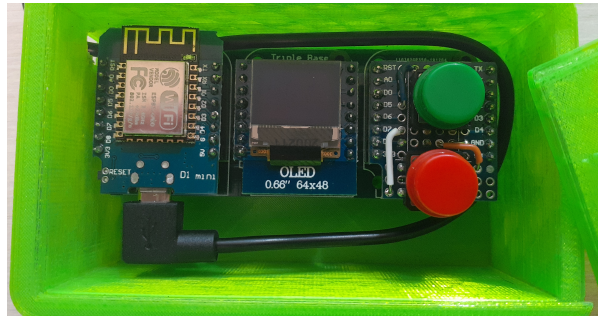
Figure 4. In-hand control and status